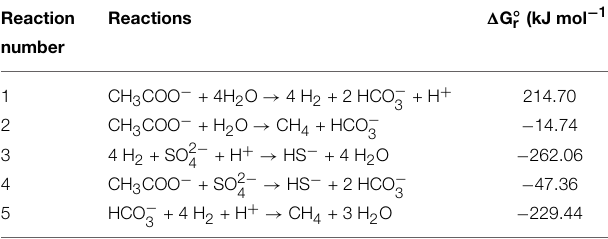
TABLE 1 | Overview of reactions examined in this study. Reaction Reactions